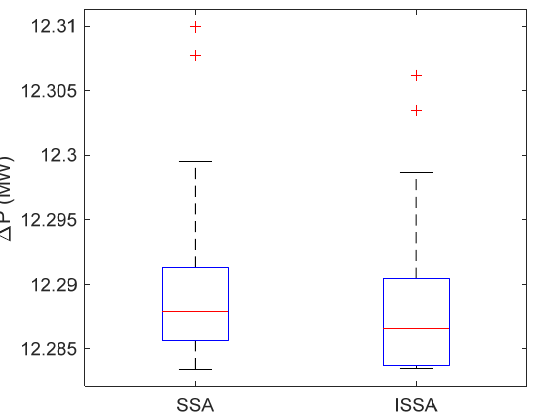
Figure 3. Boxplots of SSA and ISSA for power losses minimization for IEEE 14-bus system. Voltage Deviation (VD) Minimization